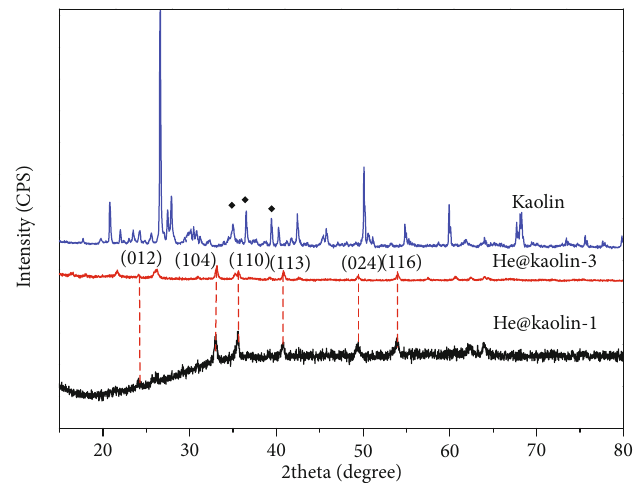
Figure 2: XRD patterns of kaolin, He@kaolin-3, and He@kaolin-1.